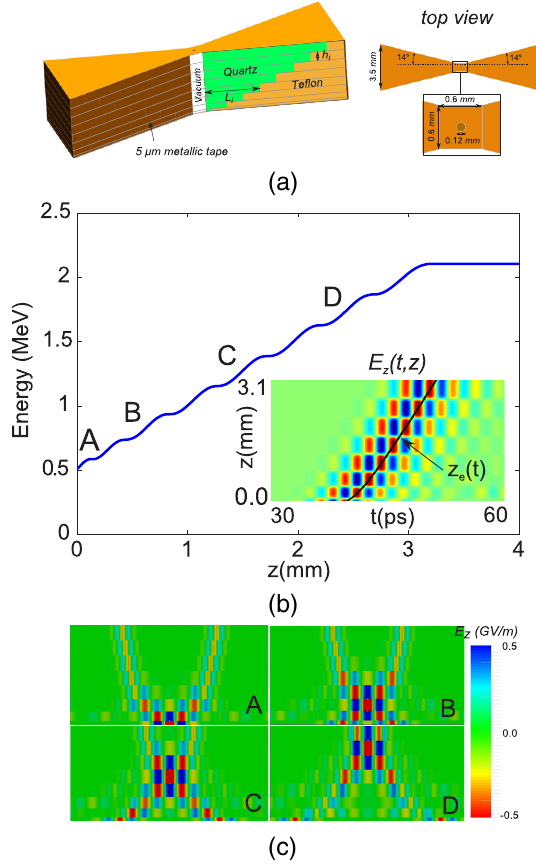
FIG. 7. (a) Schematic illustration of the optimized ultrafast z Þ versus the traveled electron gun, (b) electron energy E e ð distance and position of the electron superposed on the accel- z; t Þ as the subset, and (c) snapshots of the erating field map E z ð field profile at four different instants labeled in